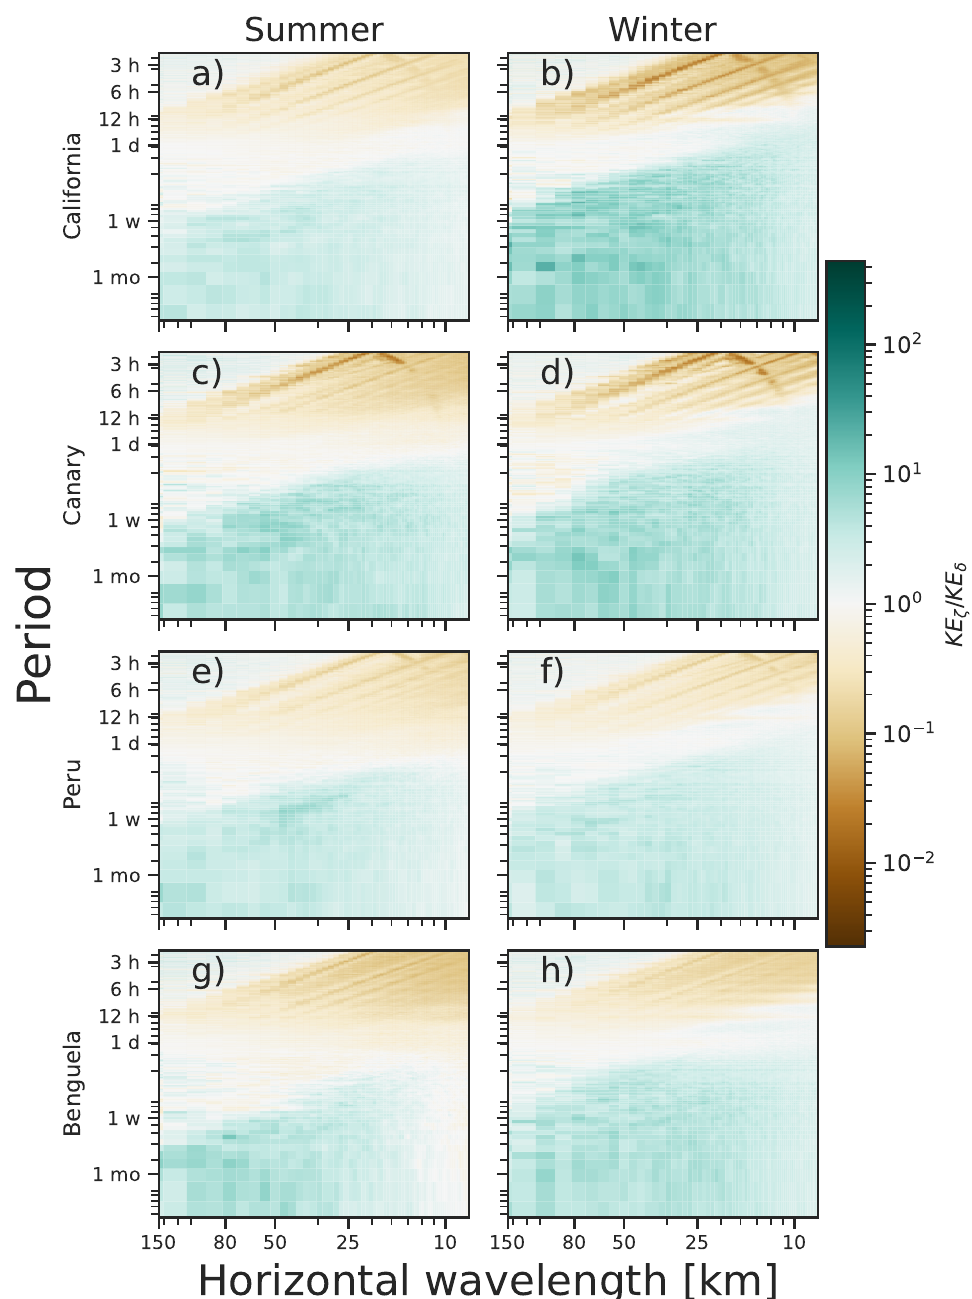
Figure 6. The quotient of spectral densities KE ζ / KE δ in the frequency–horizontal wavenumber domain by current and season at selected areas within the California (26.64 ◦ N: ( a , b )), Canary (26.64 ◦ N: ( c , d )), Peru (21.61 ◦ S: ( e , f )), and Benguela (26.64 ◦ S: ( g , h )) current systems. Green and orange highlight scales where either KE ζ or KE δ dominate,